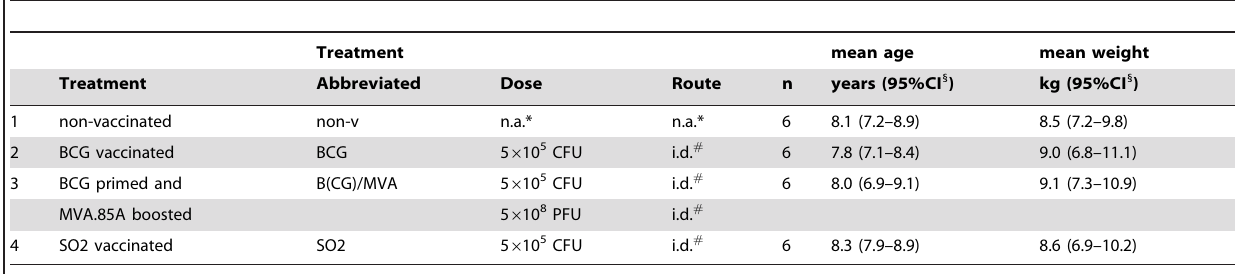
Table 1. Treatment groups, dosing, routing and group